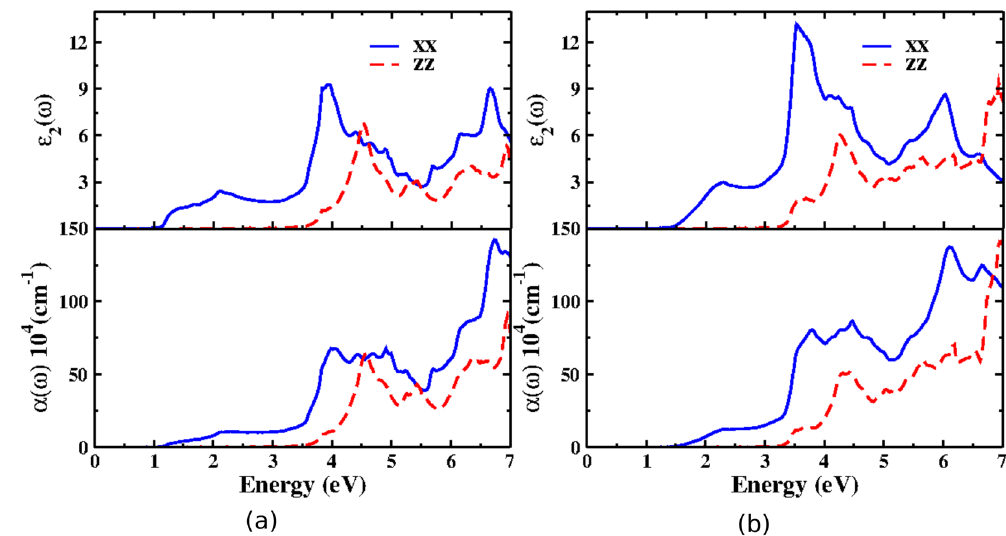
Figure 4. Optical properties: Profiles of imaginary part of dielectric function and optical absorption coefficient for ( a) KCuSe and ( b ) KCuTe along xx and zz with